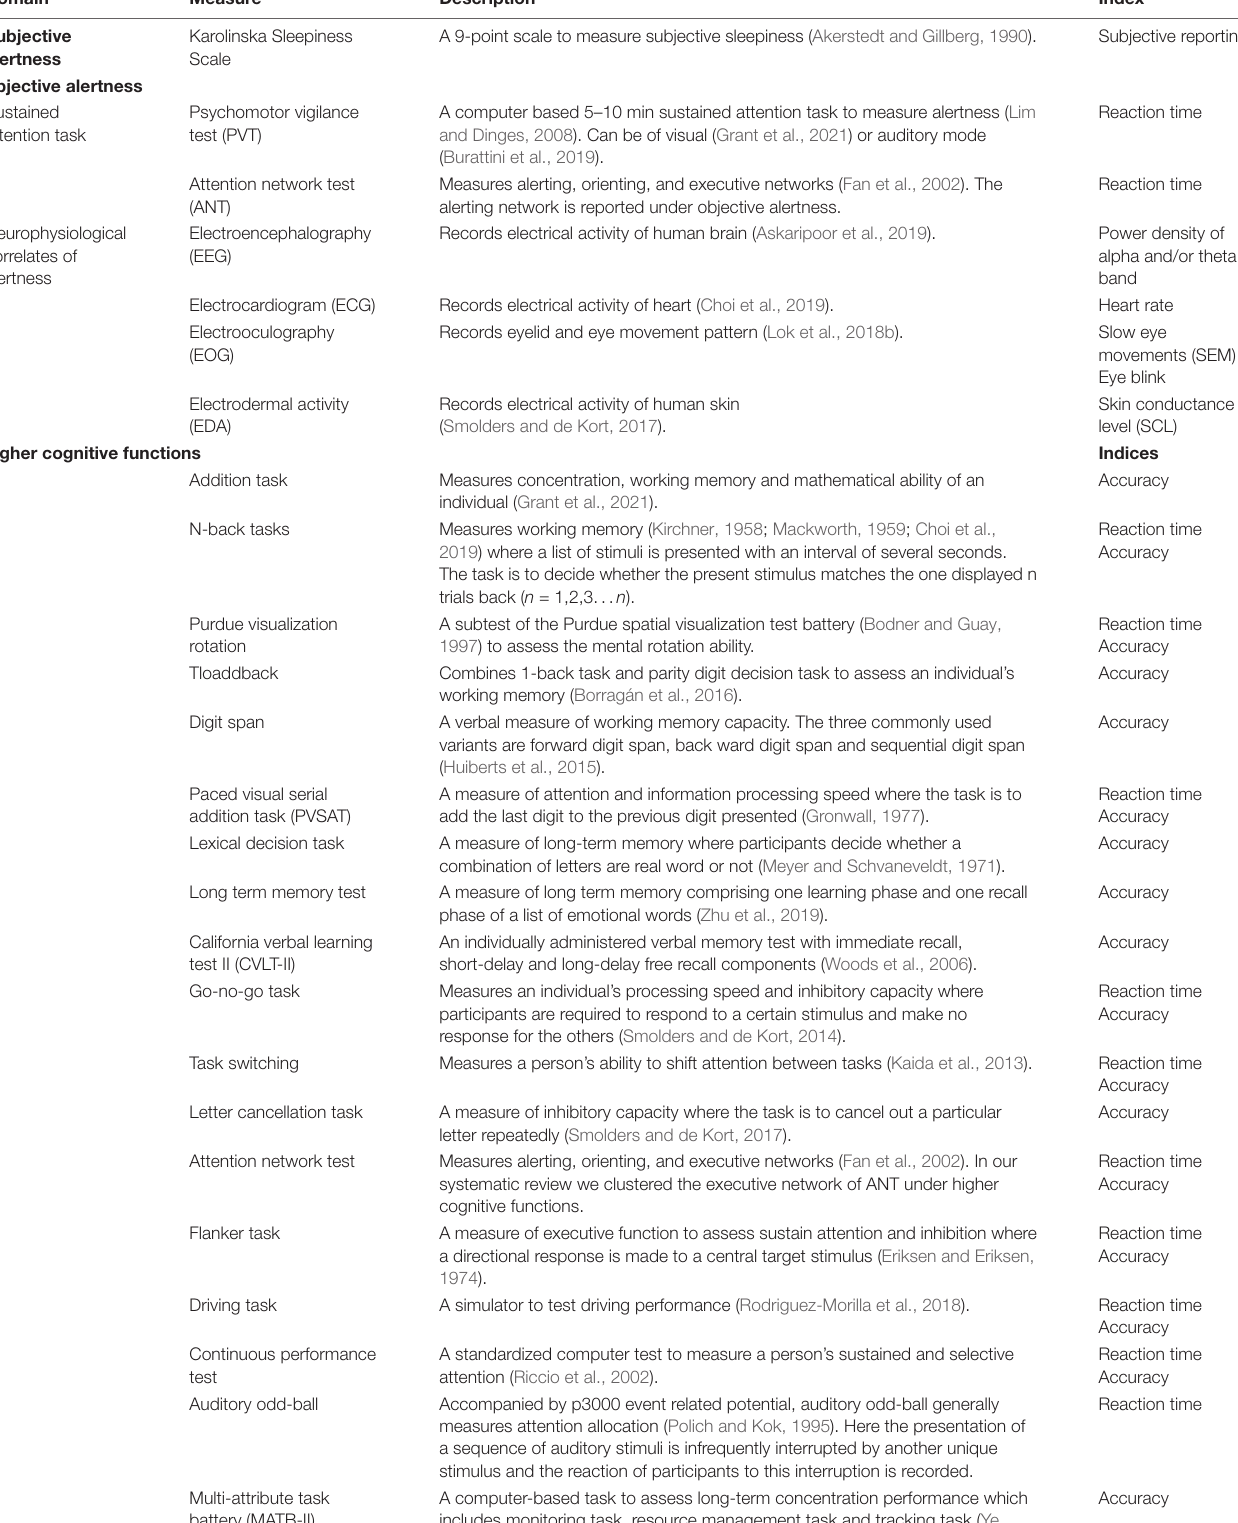
TABLE 2 | Different physiological and cognitive measures of alertness and higher cognitive functions. Domain Measure